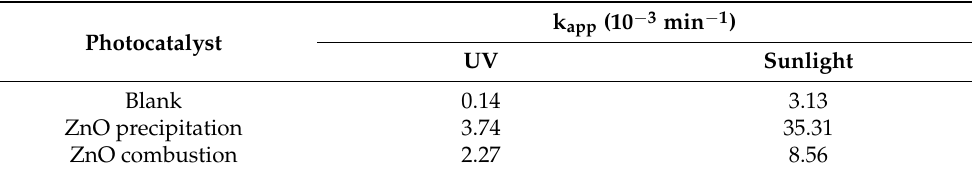
Figure 10. Photocatalytic performance of MB under UV light: ( a ) plot of A/A 0 analysis, and ( b ) apparent degradation rate constant analysis. Table 1. Apparent degradation rate constant for photocatalytic degradation of MB under UV and natural sunlight irradiation using ZnO